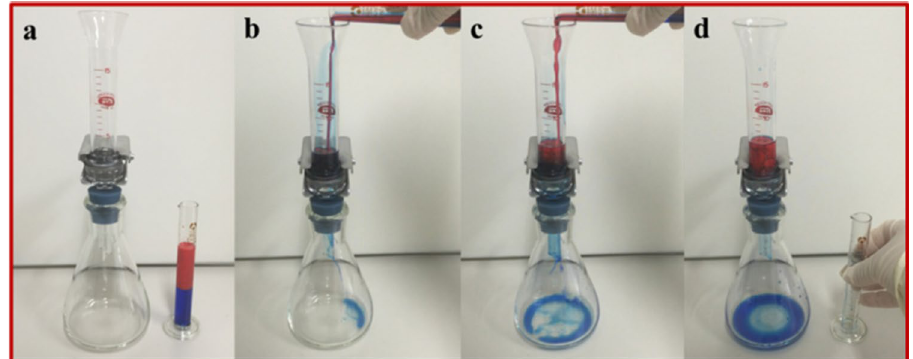
Figure 4. The oil–water separation application of the superhydrophobic coating: ( a ) color-dyed oil–water mixture was prepared to be separated by the separation device. ( b ) The oil–water mixture was mixed uniformly and poured into the device. ( c and d ) The oil–water mixture was successfully separated.